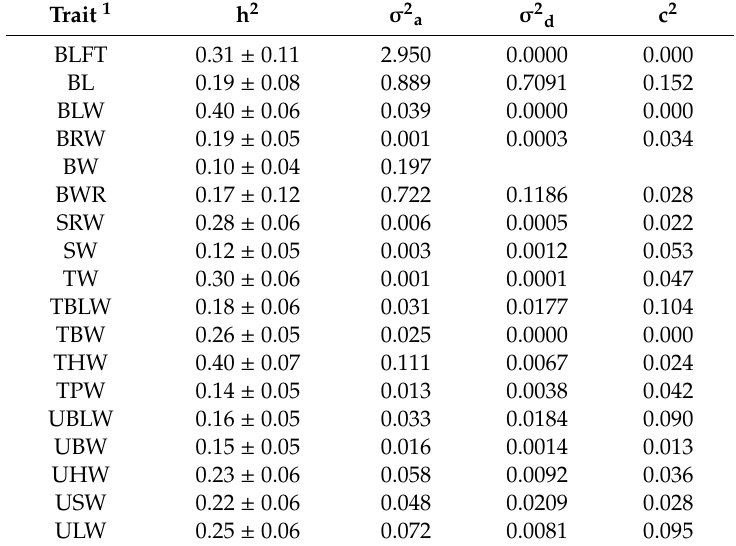
Table 7. Estimates of heritability (h 2 ), additive genetic variance ( σ 2 a ) and variance for the permanent environmental e ff ect of dam-litter ( σ 2 d ) for novel carcass